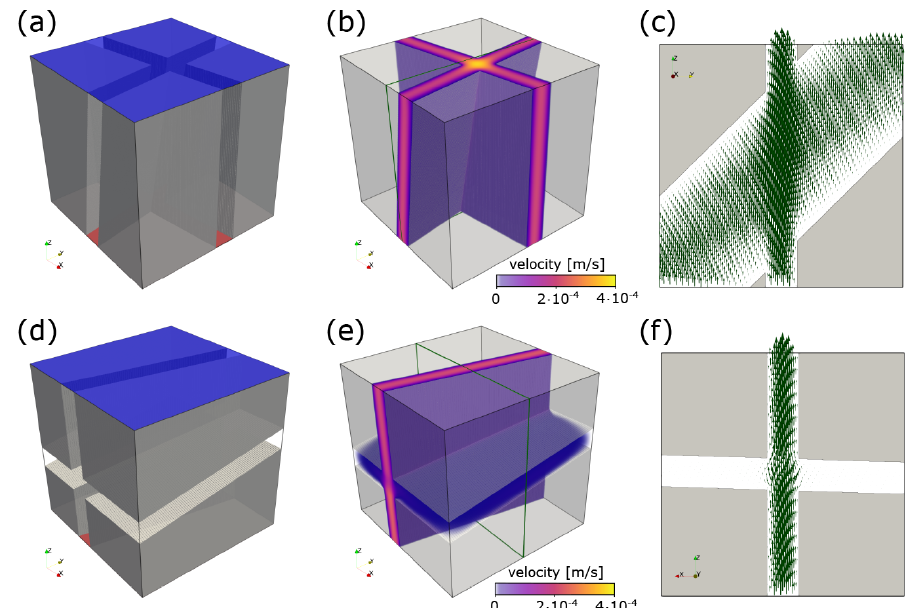
Figure 1. Panels (a, d) show the binary voxel models (impermeable matrix in transparent gray) for a fracture intersection that is oriented along and transverse to the flow direction, respectively. The red bottom face is the high-pressure boundary (0 . 02Pa) and the blue top face the low-pressure boundary (0 . 01Pa), forcing the fluid to flow in the z direction. The orientations (arranged as dip direction / dip) for the fracture pair in (a) are f 1 = 100 / 90, f 2 = 190 / 80 and f 1 = 170 / 90, f 2 = 260 / 10 for the fractures in (d) . The length of both cubes is 1cm, and all fracture apertures are constant (1 . 25mm). Panels (b, e) visualize flow velocity distribution in the void space. Panels (e, f) highlight velocity vectors within the intersections at slices indicated with green rectangles in (b, e) , respectively.